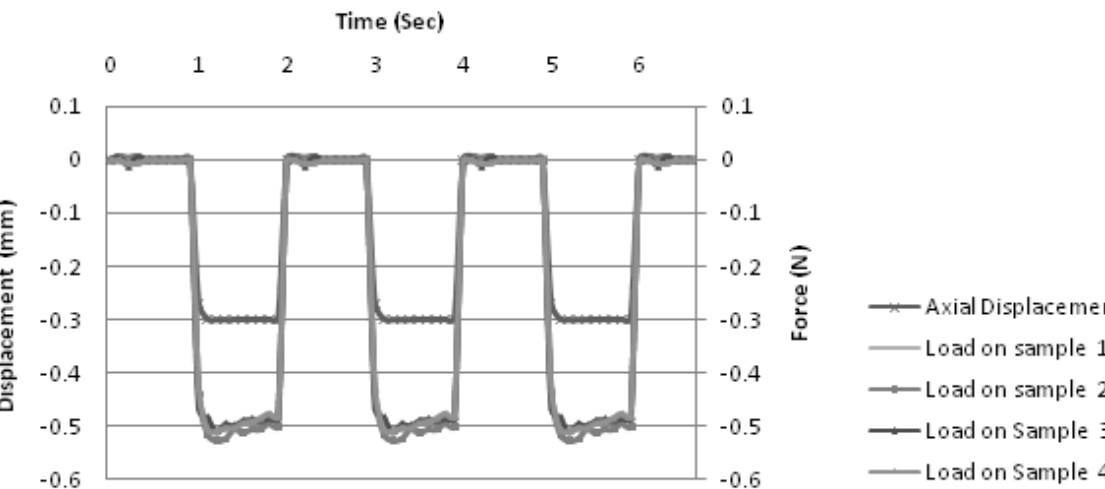
Figure 4. Proportional-integral-differential tuning. In this instance, a square wave of +0/−0.3 mm in axial displacement was applied to the samples. Within WinTest ® interface, the P, I and D components were incrementally adjusted until a square wave is consistently generated by the system as shown in the figure. The graph also shows the applied force (in Newtons) experienced by the samples during the tuning. All four samples show similar load values indicating that each sample platen is assembled to the same standards. Small variations in load values are expected as the quality of the collagen scaffolds may